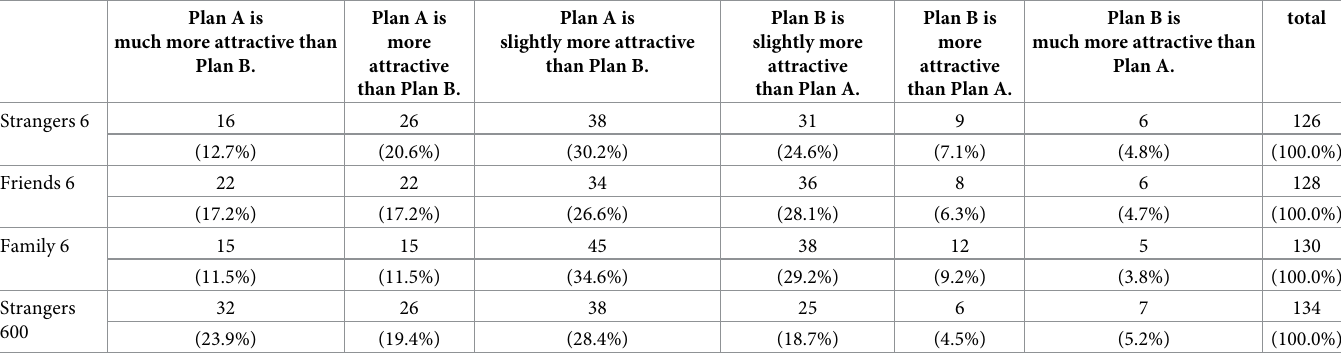
Table 3. Frequencies and percentages of choice in the Life-Death problem across 4 categories (positive frame). Plan A is much more attractive than Plan